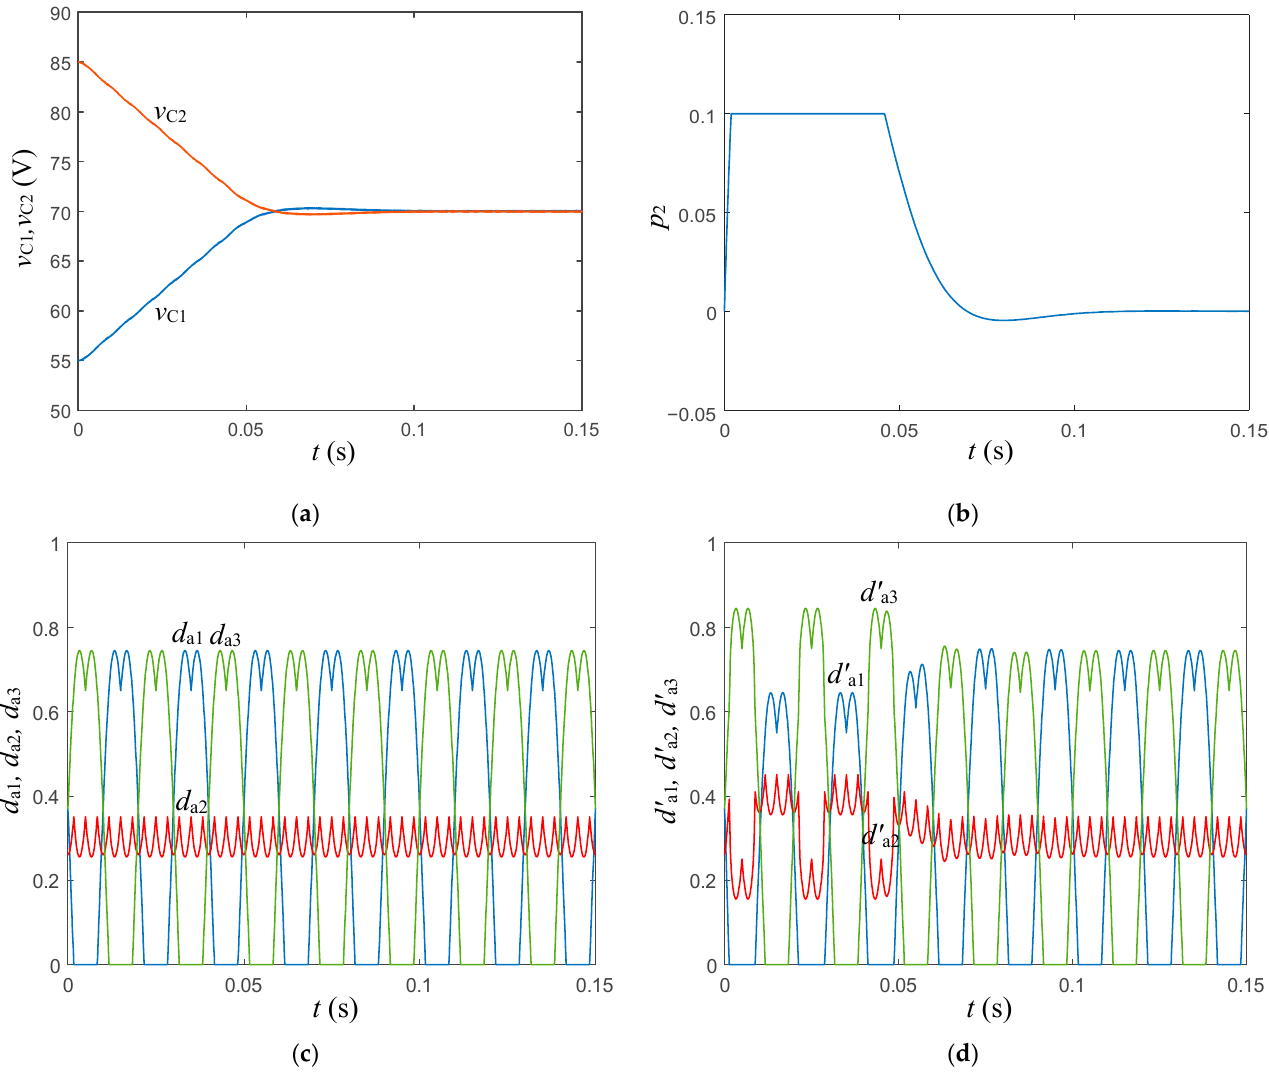
Figure 14. DC-link capacitor voltage balance recovery transient for the 3-level NPC [102]: ( a ) DC-link voltages v c 1 and v c 2 ; ( b ) control effort variable p 2 to recover the voltage balance; ( c ) original phase-a duty ratios; ( d ) perturbed phase-a duty ratios.